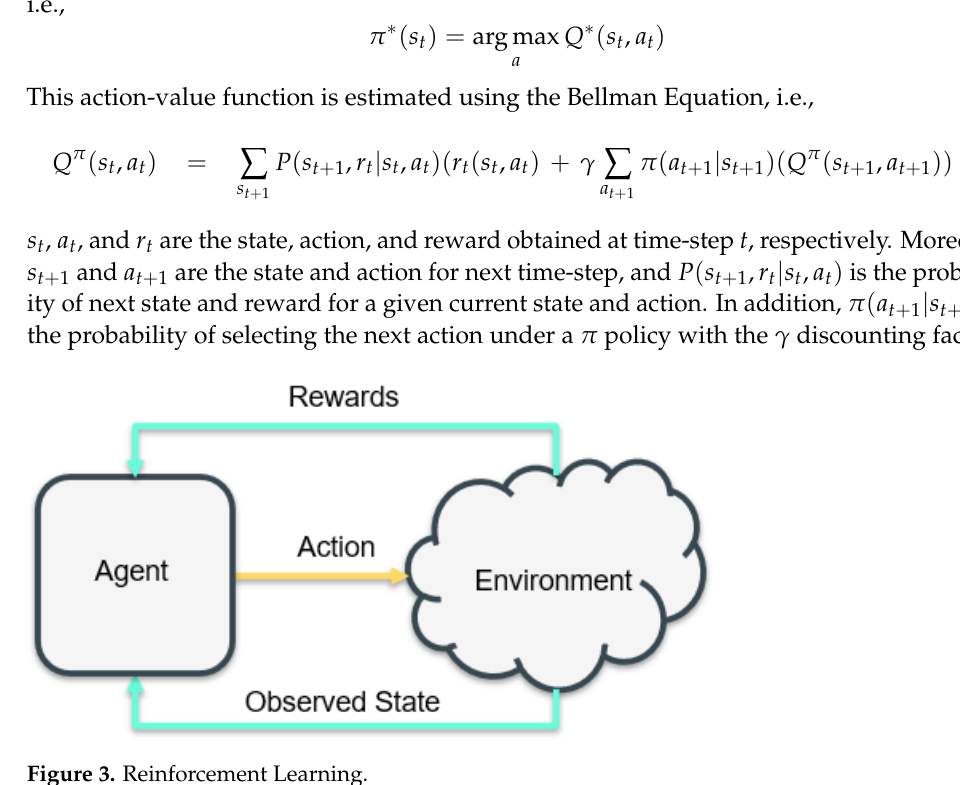
Figure 3. Reinforcement